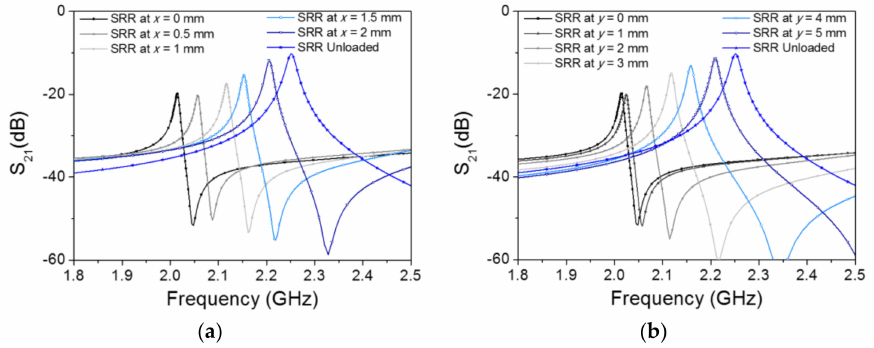
Figure 10. Electromagnetic simulation of the transmission coefficient for the channel line with SRR on top of it and the indicated longitudinal ( a ) and lateral ( b )